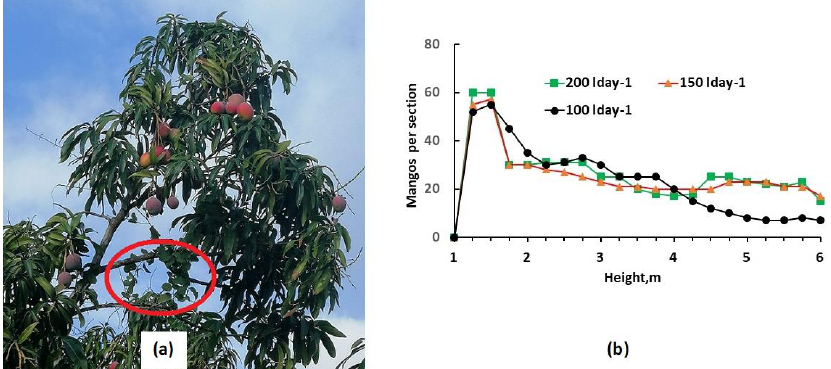
Figure 17. Mature tree ( a ) with low quantity of fruits at the top, and ( b ) fruits per section under different irrigation treatments.